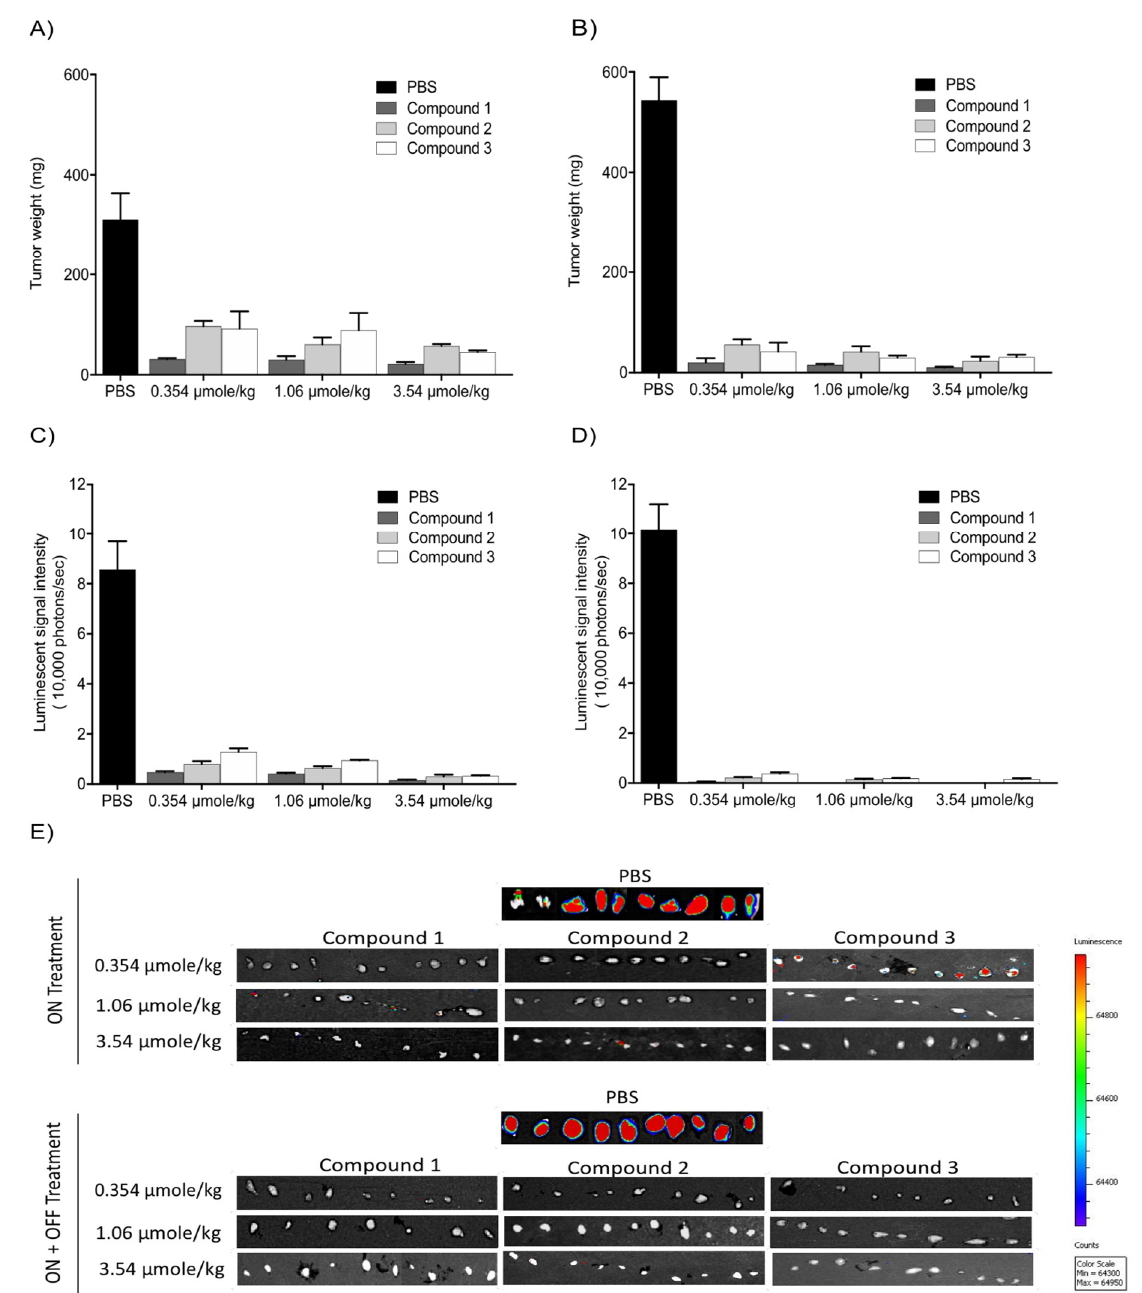
Figure 7. Antitumor effects of Compounds 1 , 2 , and 3 on xenografts. ( A , B ) Tumor weight; ( C , D ) luminescence signals in xenografts; ( E ) representative IVIS images of luminescent signals in tumors. Values are presented as the mean ± S.D.